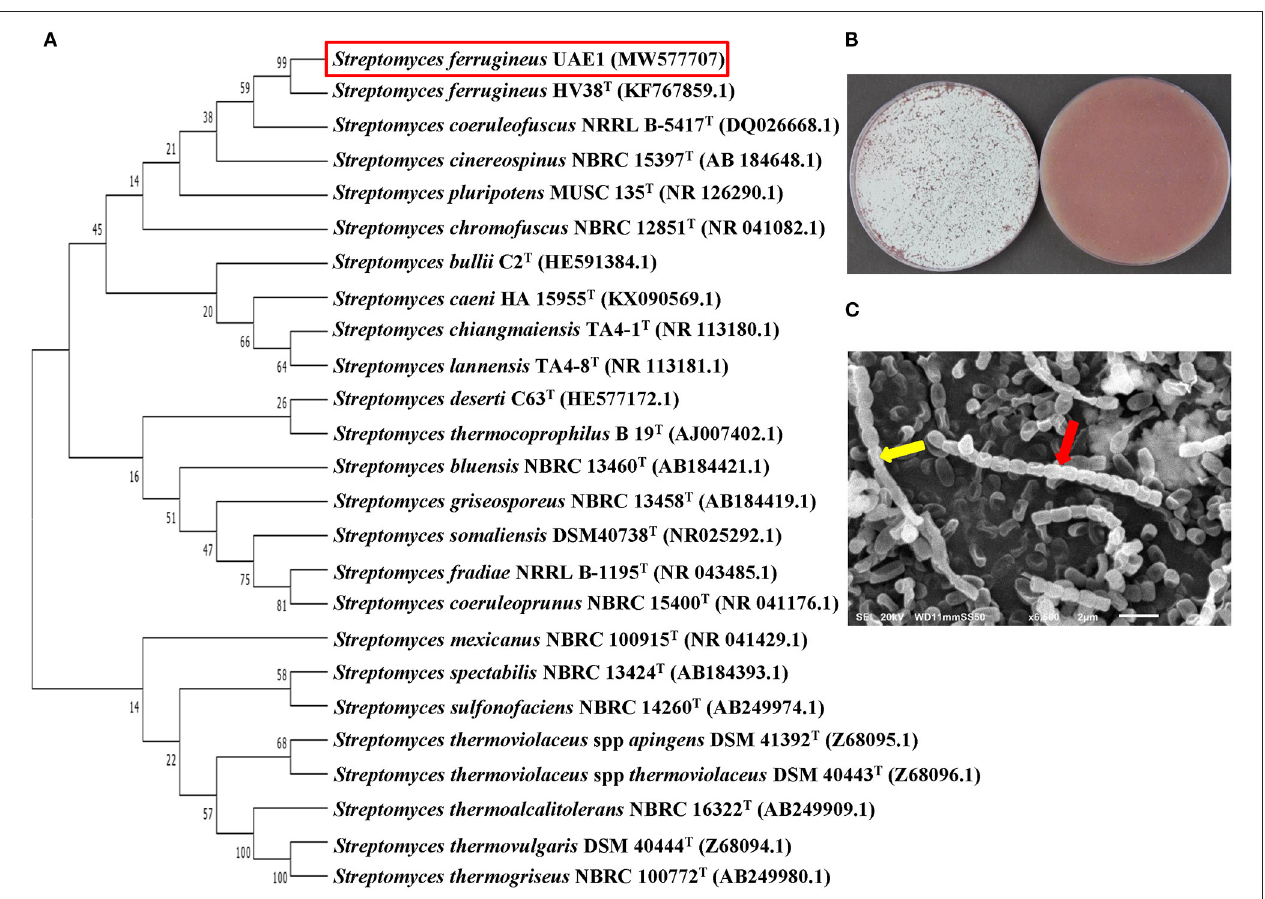
FIGURE 3 | Taxonomic identification of the ACCD-producing Streptomyces ferrugineus ( Sf ) UAE1. (A) The dendrogram showing the phylogenetic relationships between Sf UAE1 (isolate #37; MW577707) and other members of Streptomyces spp. based on 16S ribosomal RNA (rRNA) sequences. (B) whitish-greenish gray aerial (left) and red substrate (right) mycelia growing on ISP3 medium supplemented with yeast extract; and (C) scanning electron micrograph (6,500X) of the rectiflexibiles spore chains (red arrow) and smooth-surfaced spores (yellow arrow) of Sf UAE1. In (A) , numbers at nodes indicate the percentage levels of bootstrap support based on a neighbor-joining analysis of 500 resampled data sets. GenBank accession numbers are given in parentheses. ACCD, 1-aminocyclopropane-1-carboxylic